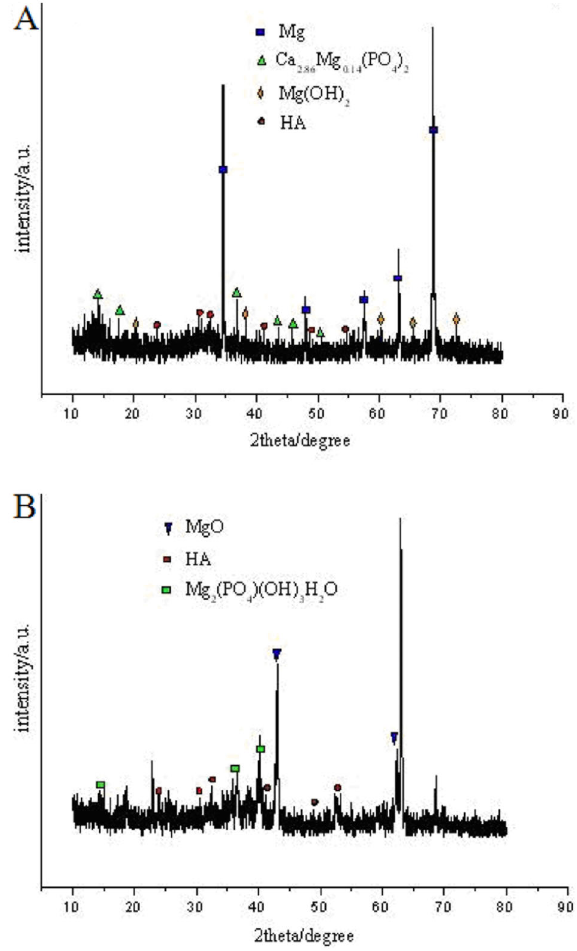
Figure 4. X-ray diffraction analysis pattern of the corrosion products of untreated Mg ( A ) and MAO-treated Mg ( B ) after immersion in simulated body fluid for 14 days. MAO: micro-arc